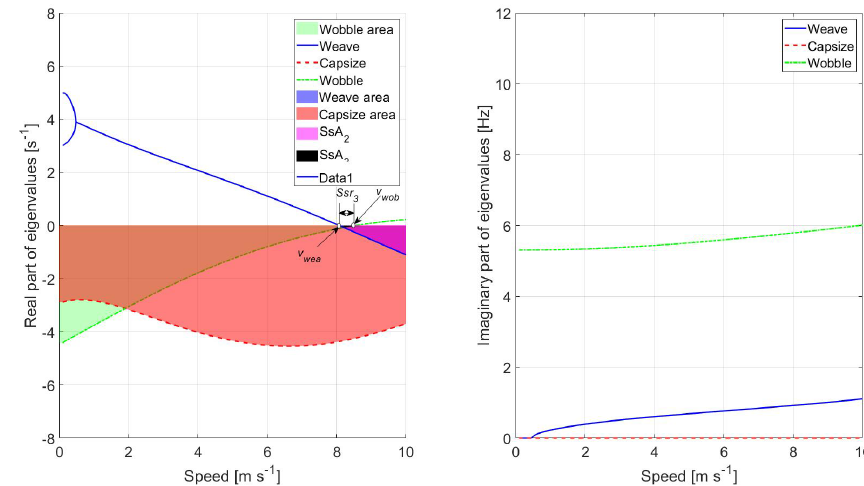
Figure 5. Eigenvalues against speed using the complete model and the nominal parameters in Tables 1 and 2,